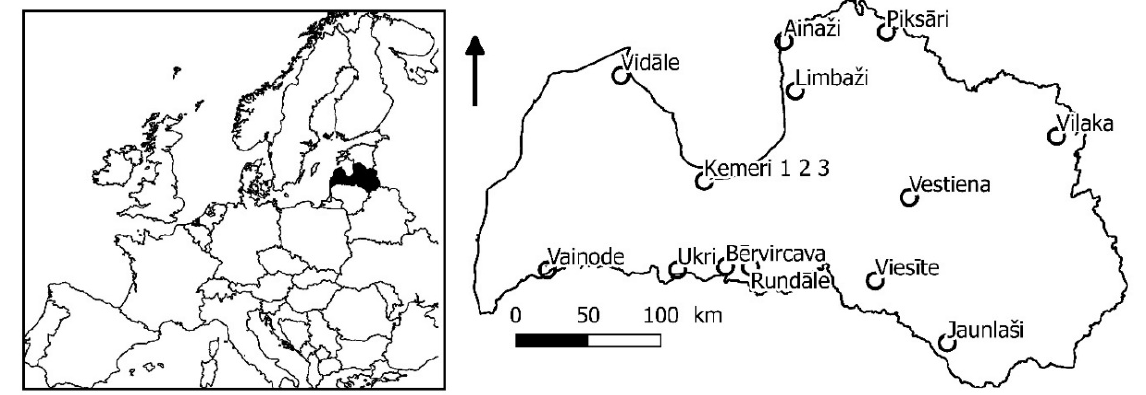
Figure 1. Location of the studied permanent sampling plots. Climatic conditions in at the permanent plots can be classified as moist continen- tal, though the locations of the sites represent local climatic gradient from coastal (west) to inland (east). Accordingly, the mean annual temperature (during 1980–2020) was 6.7 ± 0.9 and 6.4 ± 0.8 ◦ C at the coastal and inland sites, respectively [54]. February and July were the coldest and the warmest months with mean monthly temperature ranging − 2.9 ± 3.3– − 4.3 ± 3.8 ◦ C and 17.1 ± 1.6–17.7 ± 1.7 ◦ C. The annual sum of precipitation in the western and eastern part of Latvia was 700 ± 90 and 687 ± 84 mm, respectively. The seasonal distribution of precipitation is uneven, with the highest monthly precipitation falling during the summer months (May–August, 74 ± 42 mm). An increase of tempera- ture during the autumn–spring period coupled with growing heterogeneity of summer precipitation regime have been the main manifestations of climatic changes [55]. The permanent sampling plots were circular, with a radius of 15 m (area of ca. 706 m 2 ). In each plot, all trees, including deadwood (log/snag), with stem diameter at breast height (DBH) ≥ 6 cm were accounted and numbered, and their coordinates fixed. For each tree (including deadwood and the recruiting ones), species, DBH and height (or length for lying deadwood) (H) were recorded with the accuracy of 1 cm and 50 cm, respectively. Such surveys were repeated four times: in 2005, 2010, 2015, and 2020. In 2005, the age of ashes was determined from increment